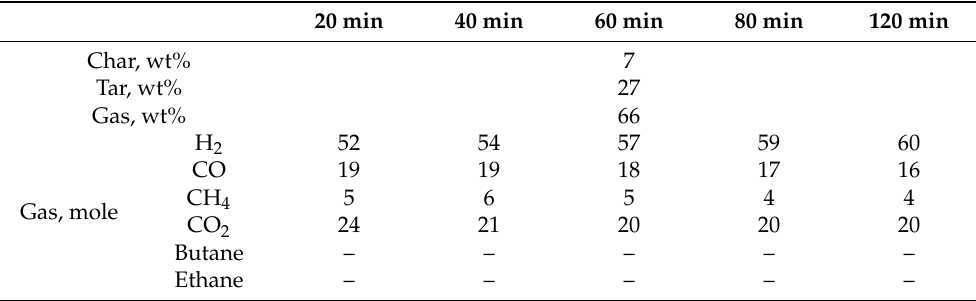
Table 27. Gas composition at 900 ◦ C and different reaction times—gasification [49].